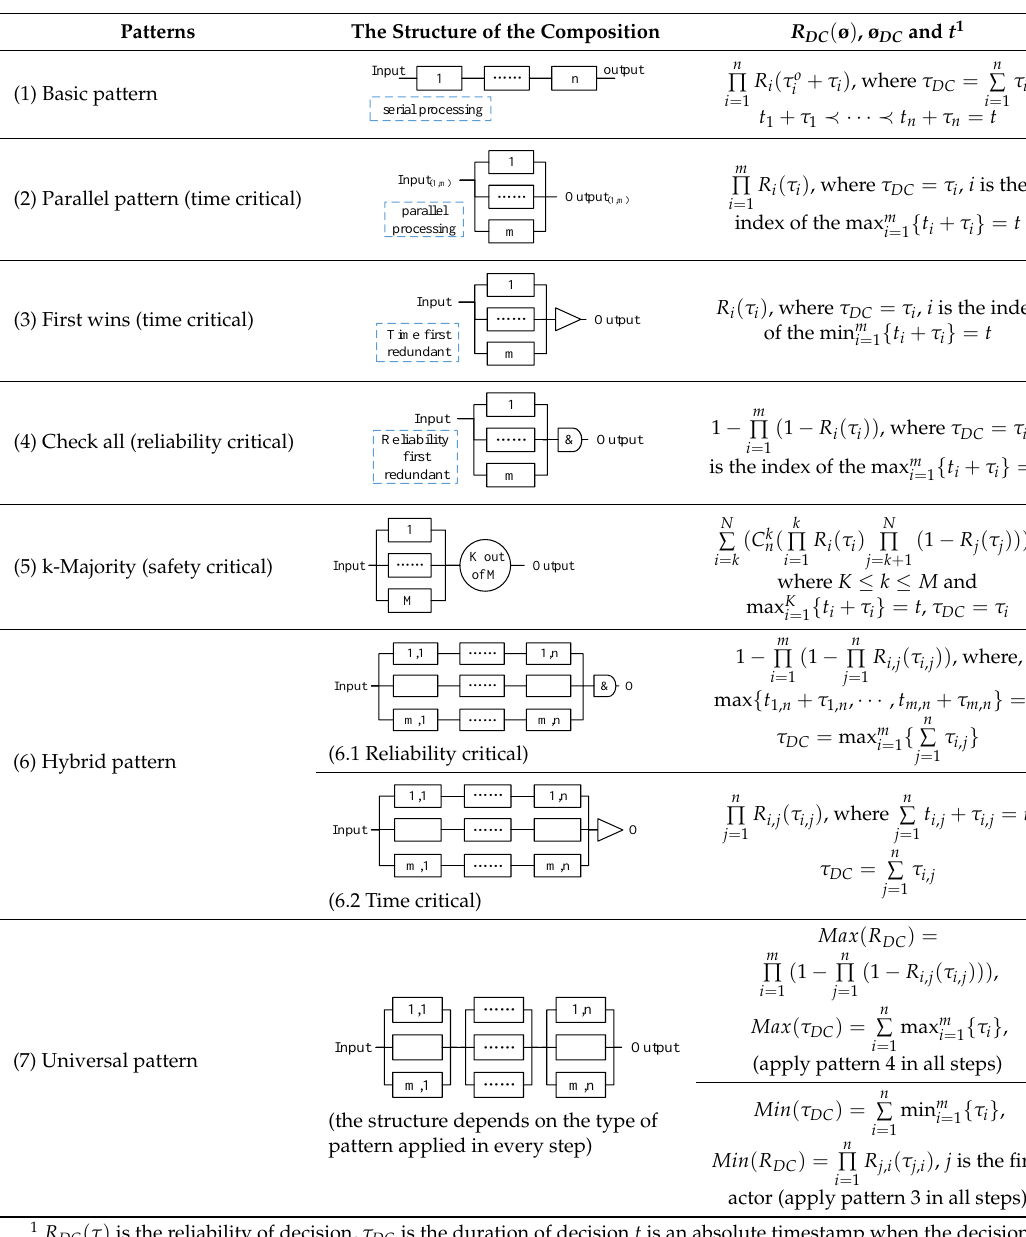
Table 3. The availability of n compositional actors is a classical Markov repairable system [49], which is briefly introduced in Appendix A.1. Table 3. The composition rules for reliability and duration. Patterns The Structure of the Composition